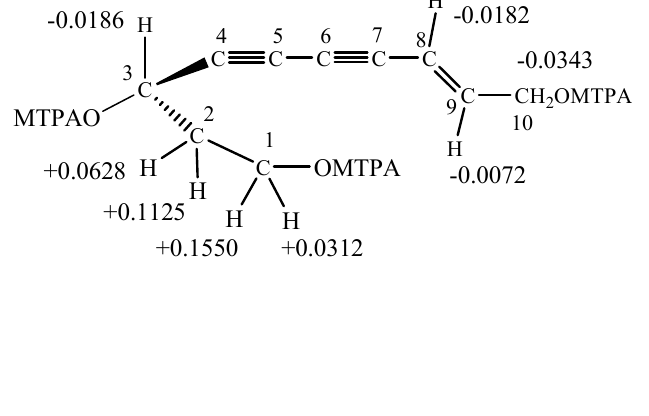
– δ values (ppm) obtained from the MTPA ester of 8 in CDCl S R